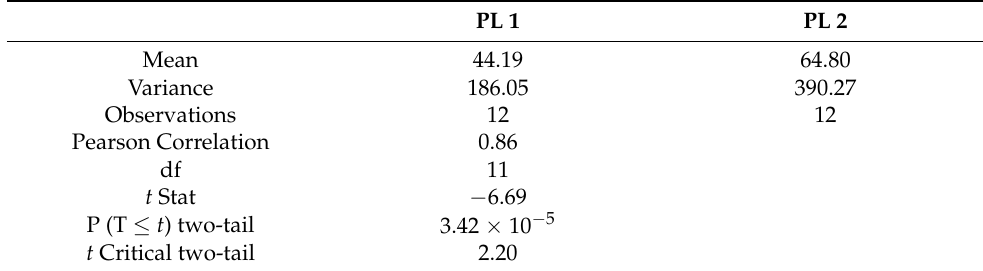
Table 9. Results of two-tailed paired t -test ( p < 0.05).